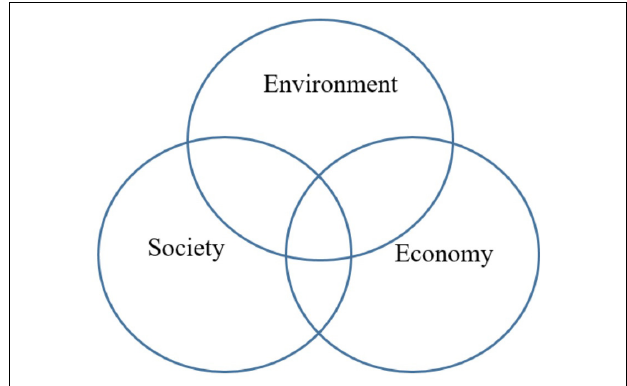
FIGURE 1 | Common diagrammatic representation of the three pillars of sustainability, adapted from Barbier (1987: 104).